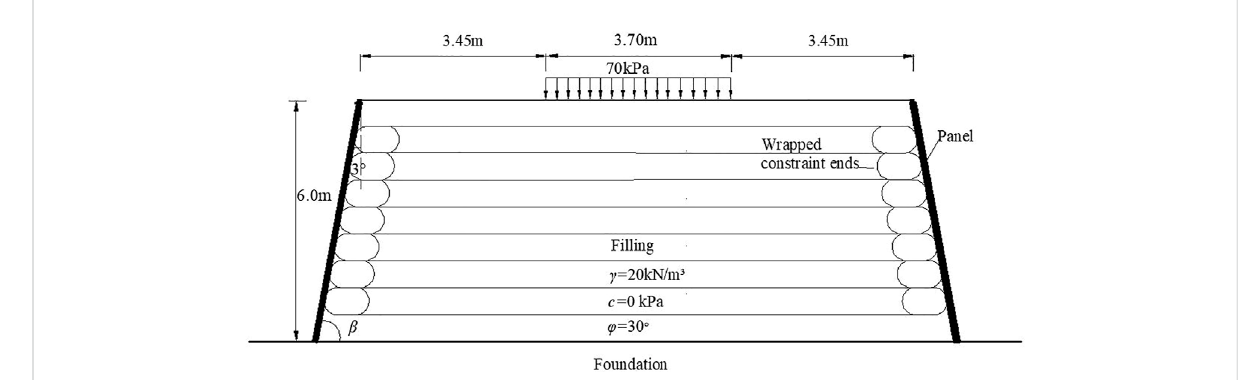
FIGURE 4 Cross-sectional diagram of a bilaterally wrapped geogrid-reinforced embankment.